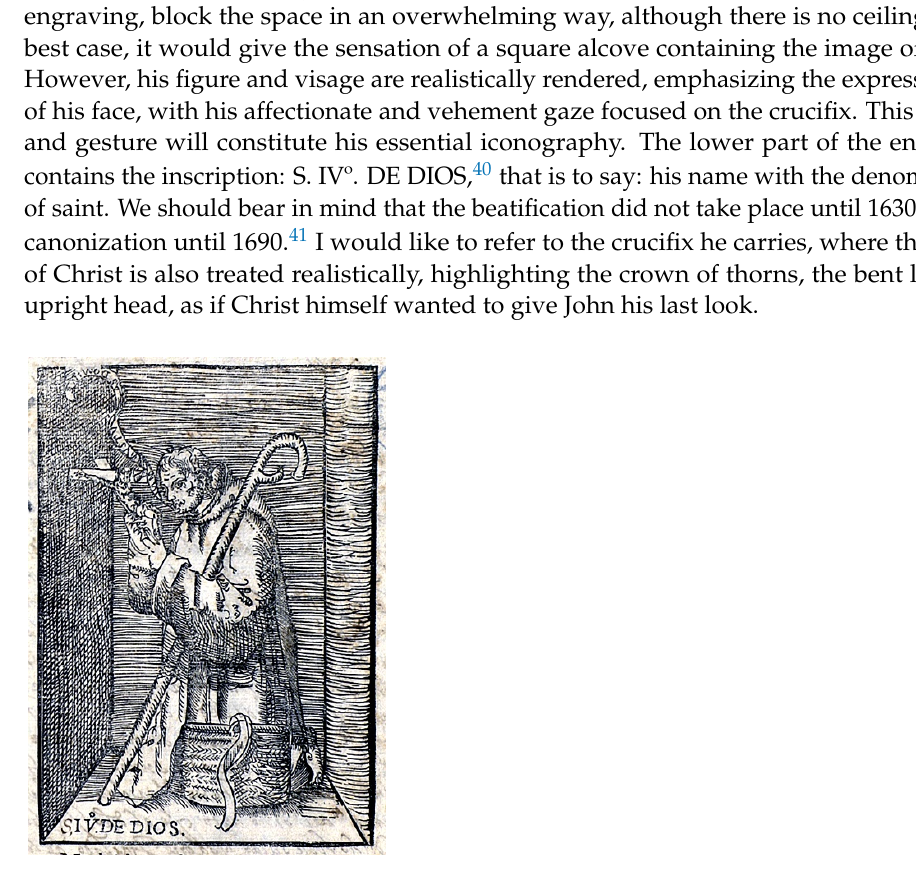
Figure 8. Anonymous. Muerte de S. Juan de Dios . Book cover of Bulas apostólicas concedidas por la san- tidad de Pio V y de Gregorio XIII y Sixto V a los Hermanos de la orden y Hospitalidad de Juan de Dios… en Madrid… en casa de P. Madrigal. 1596. (Archivo Histórico